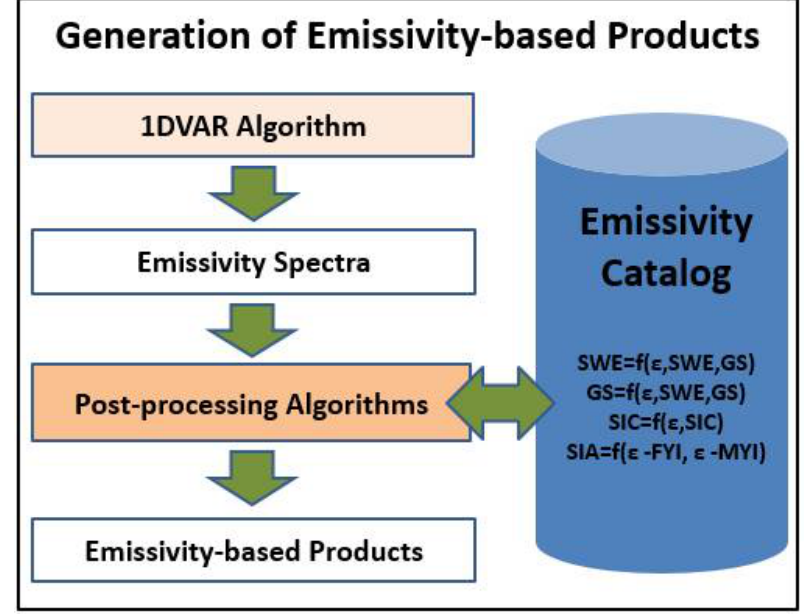
Figure 2. Illustration of MiRS emissivity-based products. The surface characteristics (Sea-Ice Concentration, SIC; Snow-Water Equivalent, SWE) are retrieved along with corresponding secondary parameters (age, grain size respectively), by matching the 1DVAR-retrieved emissivity with pre-computed emissivity spectra stored in a catalog.